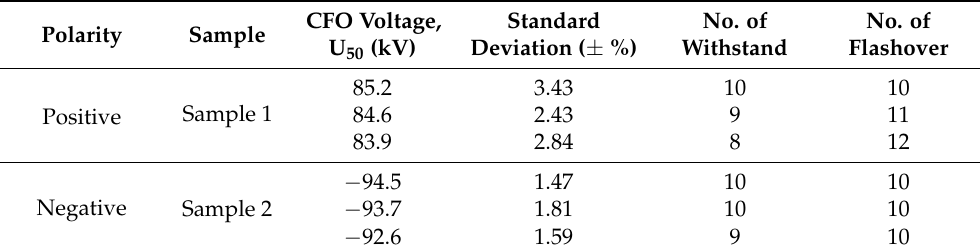
Table 3. CFO voltages of crossarm sample.